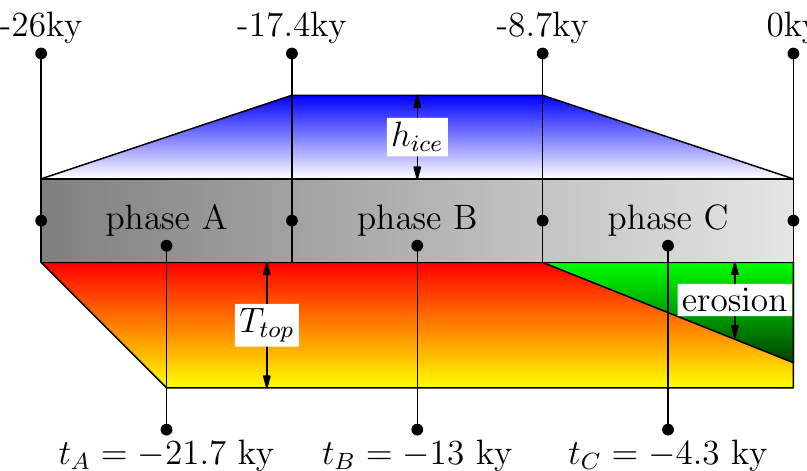
Figure 10. Timeline of the simulation. On the top we show the height of the ice, on the bottom temperature profile (red) and the thickness of the eroded material (green).